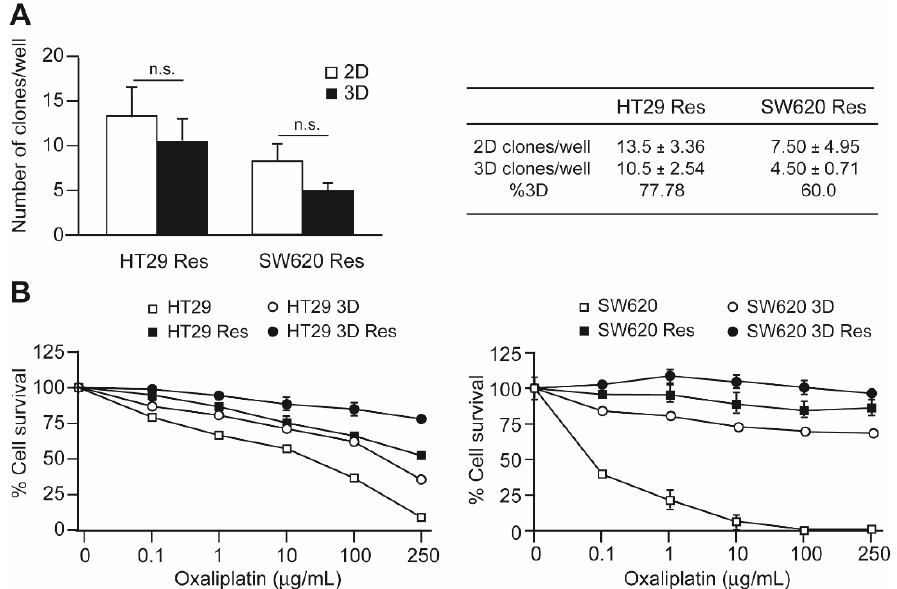
Figure 3. Clonogenic capacity and oxaliplatin sensitivity of oxaliplatin-resistant CRC cells. Panel ( A ). Oxaliplatin-resistant HT29 (HT29Res) and SW620 (SW620Res) cells were cultured in 96-well plates at a density of 46 cells/plate for 10 days. Control cells were cultured in adherent plates (2D, open squares), while CSCs were cultured in non-adherent plates and defined media (3D, black squares). The number of clones obtained in each plate is represented in the left graph and indicated in the table to the right. Panel ( B ). Oxaliplatin sensitivity was determined by culturing the HT29 (left panel) or SW620 (right panel) cells in the presence of the indicated concentrations of oxaliplatin for 3 days. Cell survival was determined for each point and represented as percentage of survival in relation to the cell culture in the absence of the drug. Open squares represent the original cell population, black squares (Res) represent the population of cells that was made resistant to oxaliplatin, open circles represent untreated cells cultured under non-adherent (3D) conditions, and black circles represent oxaliplatin-resistant cells cultured under non-adherent conditions (3D Res). Experiments were repeated three times with similar results. Statistics: NS: non-significant differences.